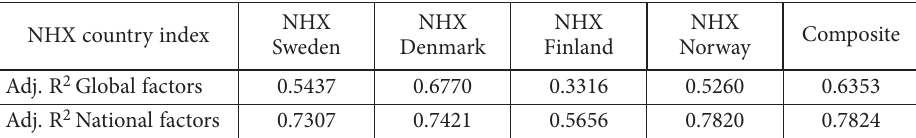
Table 7. NHX country index model comparison